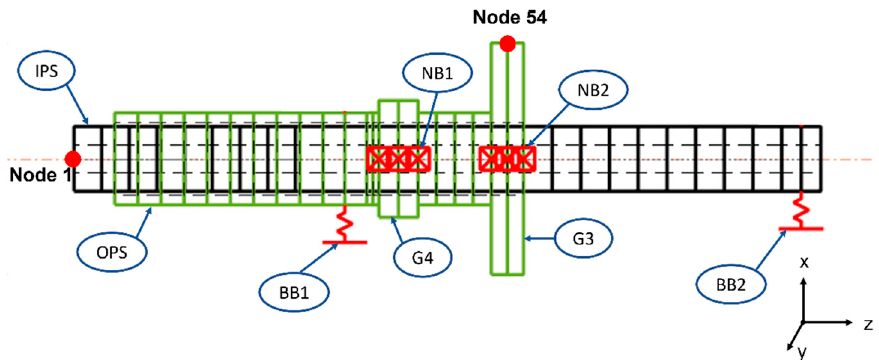
Figure 10. ICE + EM in 4th gear boost result.